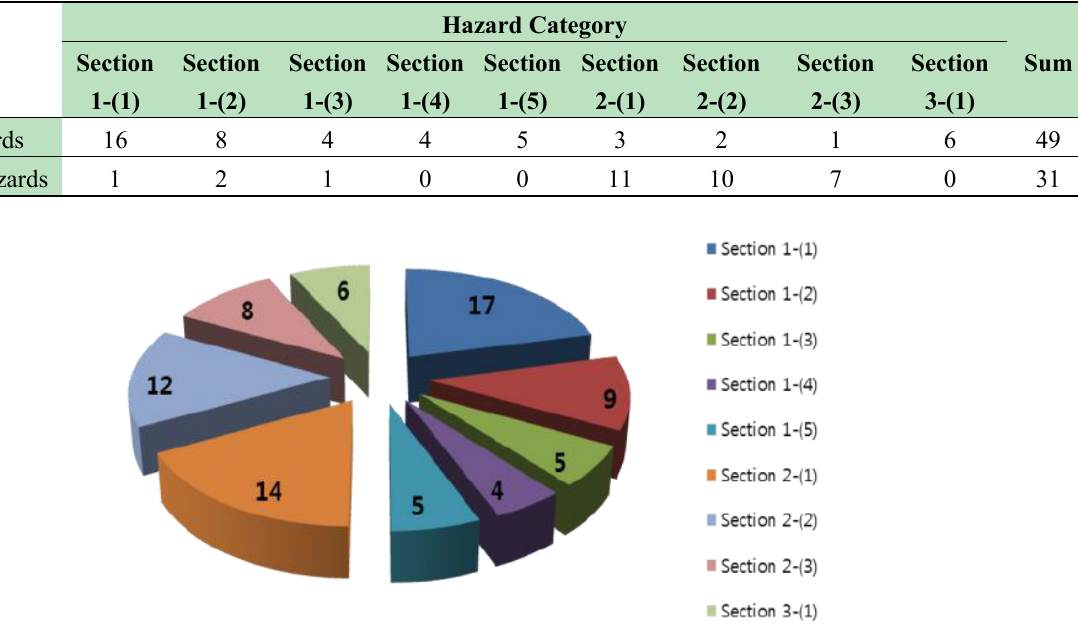
Table 7. Number of hazards by hazard category.